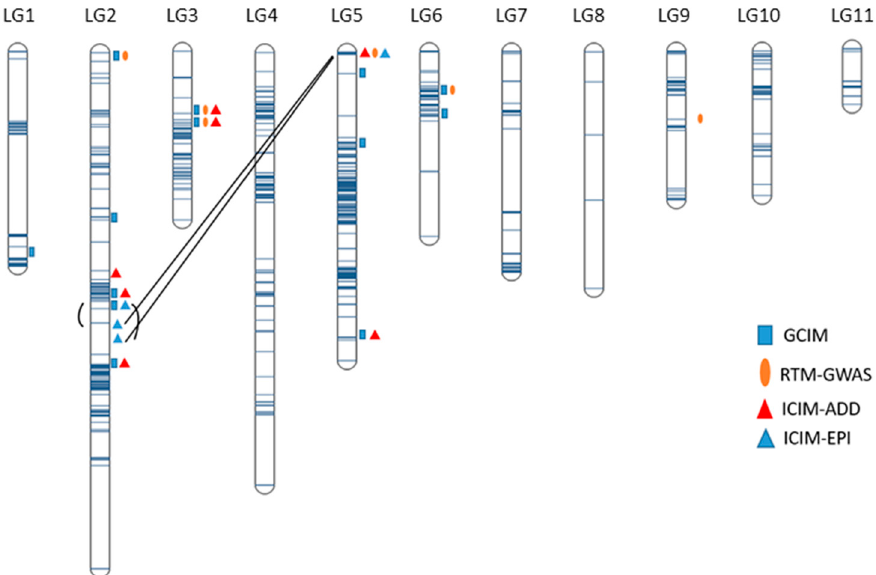
Figure 1. Distribution of 1273 single nucleotide polymorphisms (SNPs) in the genetic map and quantitative trait loci (QTL) associated with marsh spot resistance index (MSRI) identified using four statistical models represented in the linkage map. Two QTL with significant epistasis effects are linked by a line or a curve.